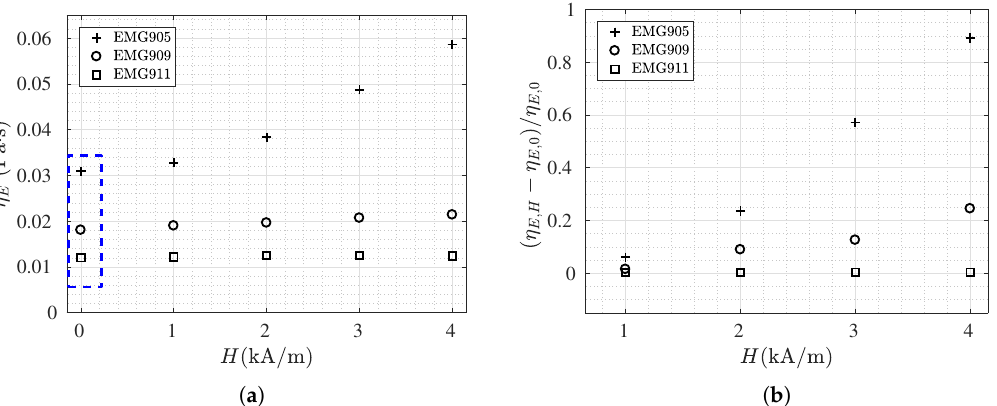
Figure 6. The figure shows the characteristic extensional viscosity ( a ) and eMVE ( b ) as a function of the field